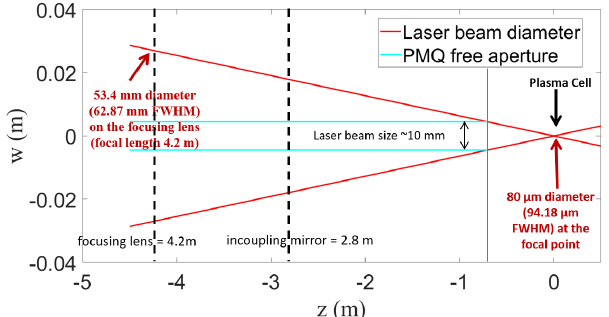
FIG. 2. Evolution of the laser beam along the direction of beam propagation. The origin here is set at the focal point of the laser beam which is the entrance position of the plasma cell. A Gaussian laser beam is